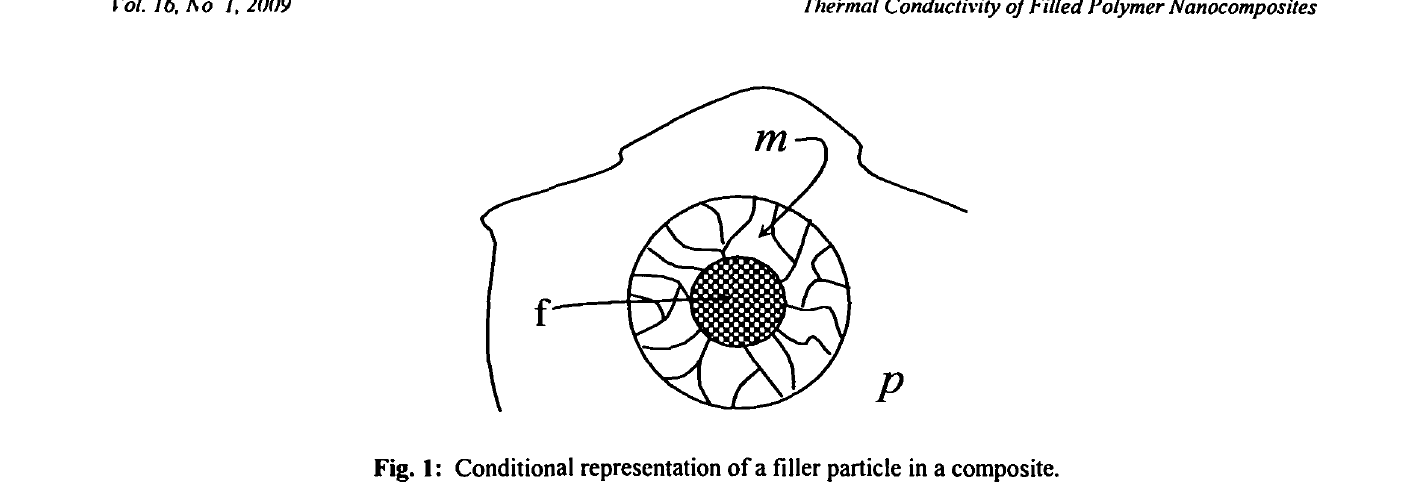
Fig. 1: Conditional representation of a filler particle in a